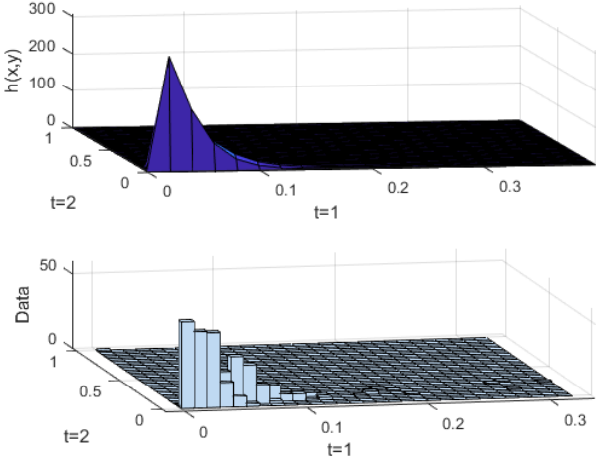
Figure 6. Results of Copula function.